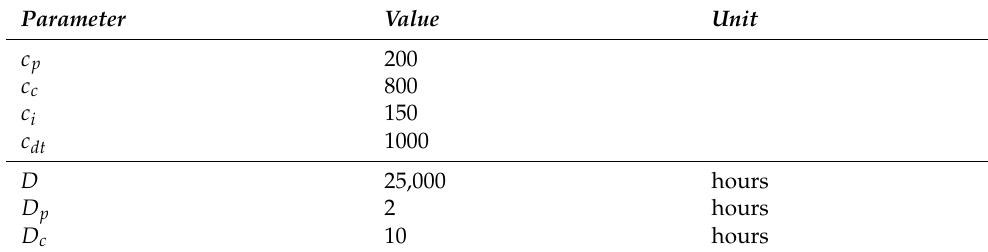
Table 2. Main characteristics of the mechanical bearing system.